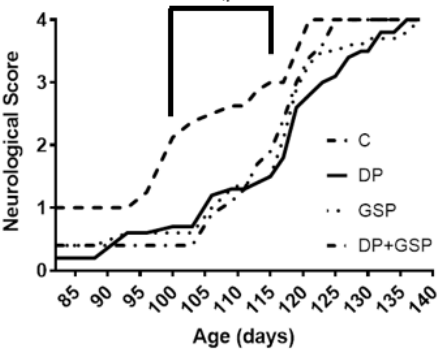
Figure 7. E ff ect of treatment on neurological de fi cit. Graph depicting progression of average neuro- Figure 7. Effect of treatment on neurological deficit. Graph depicting progression of average neuro- logical score over time. DP, GSP, and DP+GSP a tt enuate neurological de fi cit in SOD1-G93A. Note logical score over time. DP, GSP, and DP+GSP attenuate neurological deficit in SOD1-G93A. Note that there was no significant difference between treatment groups at baseline (82 days of age) up until 100 days of age. DP mice exhibited significantly lower neurological scores between days 100 and 115 (indicated by asterisk), SD+GSP mice between days 100–109 and days 113–115 (a total of 13 days), and DP+GSP mice between days 100 and 111 (a total of 12 days) ( p < 0.05). DP thus attenuated neurological deficit the longest, followed by GSP and DP+GSP, respectively. All data are represented by means.